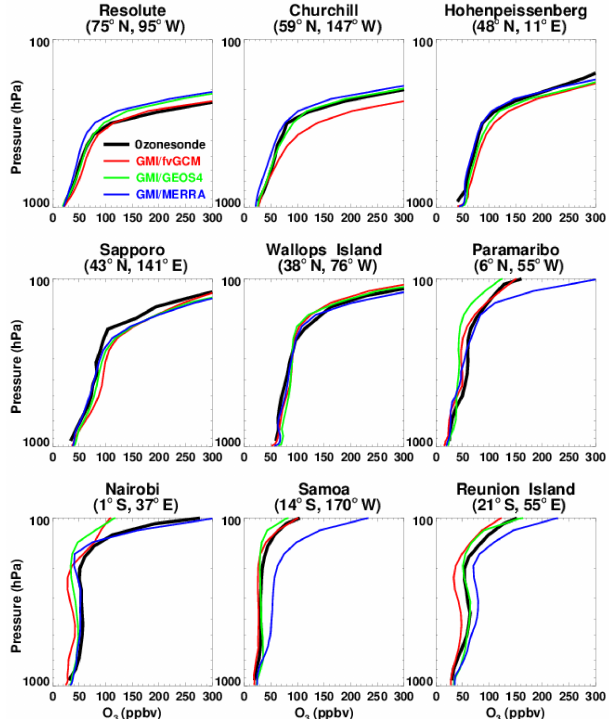
Figure 6. Comparisons of GMI-simulated tropospheric ozone pro- files (color lines) with ozonesonde observations (black line) for a range of latitudes. The model is driven by the fvGCM, GEOS-4, and MERRA meteorological fields. Values are July–August aver-